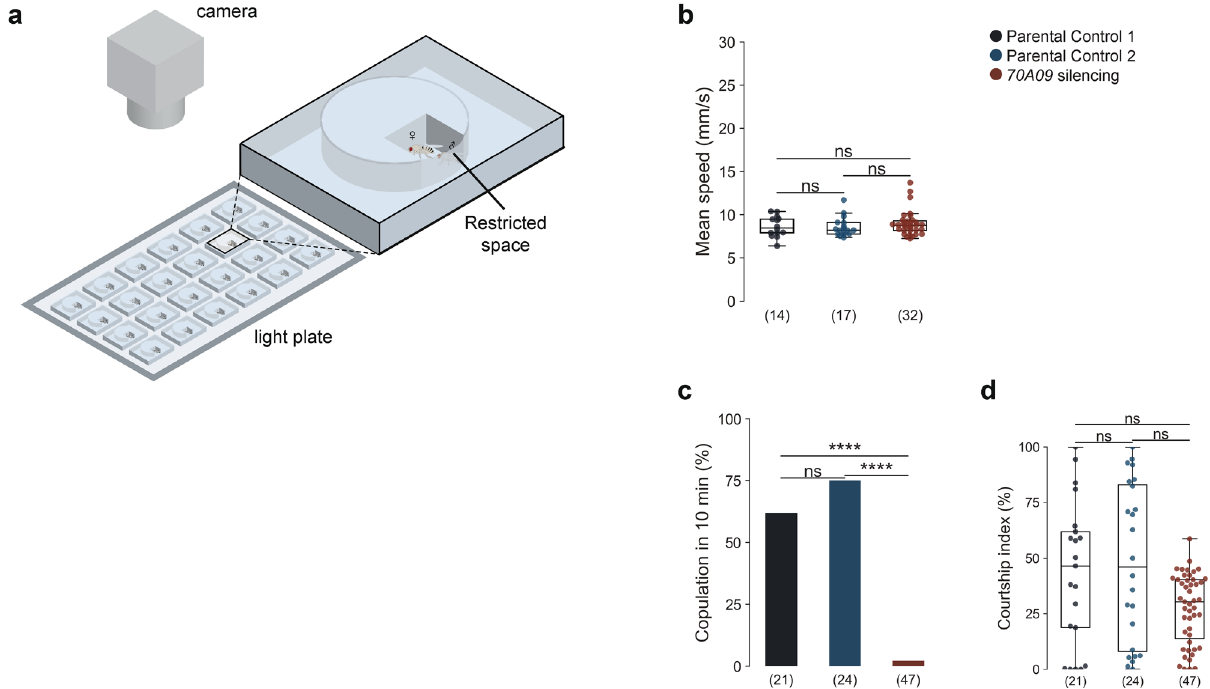
Figure 4. 70A09-silenced females remain unreceptive when escape is impeded. ( a ) Schematic representation of the behavioural setup to test female receptivity when the female is not allowed to walk away from the male. Arena drawn by Gil Costa. ( b ) Female mean walking speed (4–50 mm/s) during courtship ON periods. Genotypes: w /UAS > STOP > kir2.1; otd-nls:FLPo/ + ; + (Parental Control 1), w-; + ; 70A09-GAL4/ + (Parental Control 2) and w-/UAS > STOP > kir2.1; otd-nls:FLPo/ + ; 70A09-GAL4/ + (70A09 silencing). ( c ) Copulation rate of silenced and control females. ( d ) Male courtship index toward silenced and control females. Statistical analysis was performed with Fisher’s exact test ( c ) and, Kruskal–Wallis test followed by post hoc pairwise Dunn’s test with Bonferroni correction ( b and d ): ns not significant, ****p < 0.0001. n values are shown in